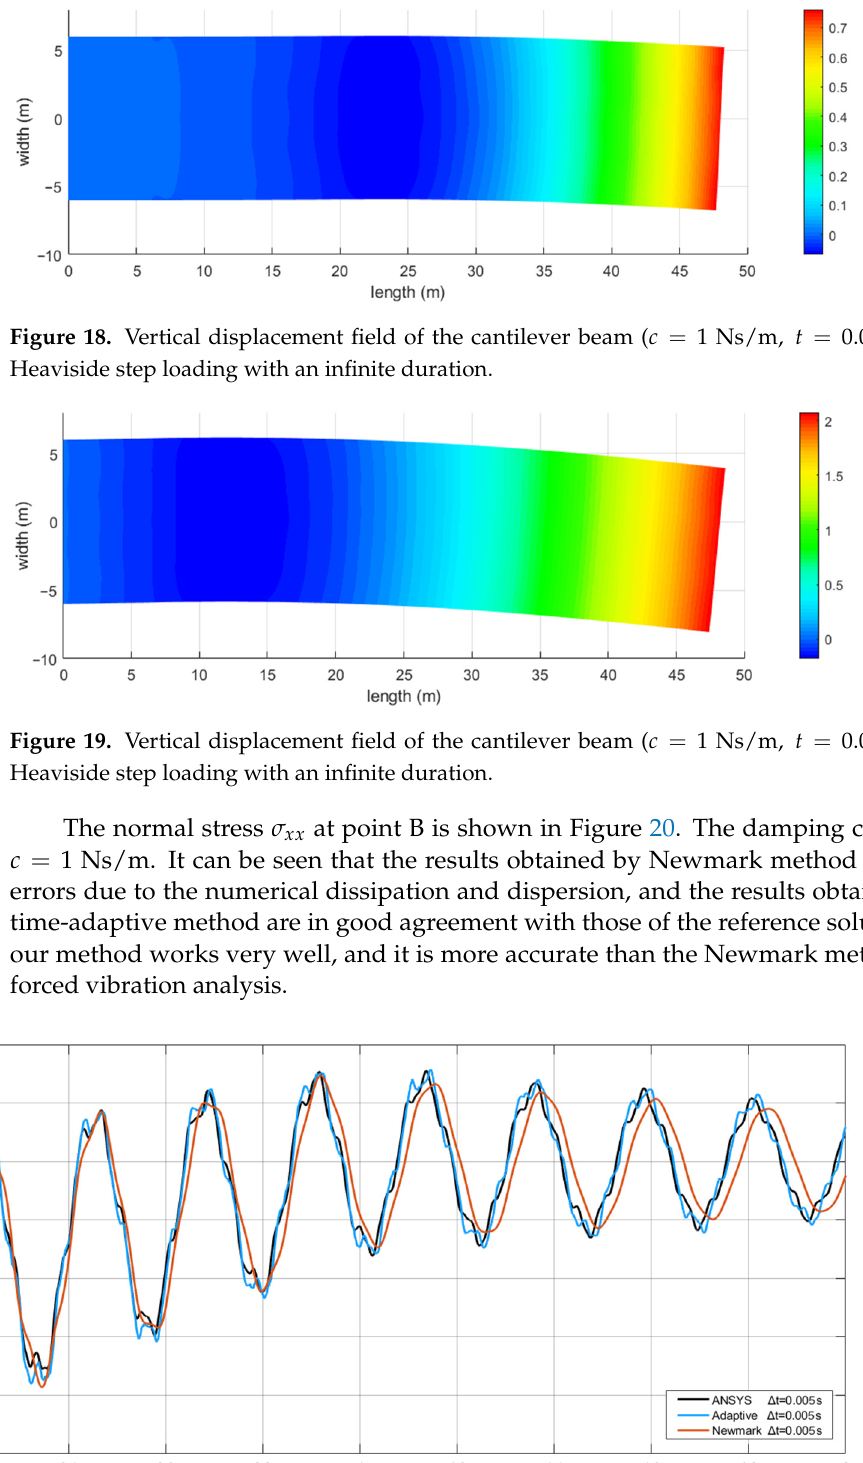
Figure 17. Vertical displacement field of the cantilever beam ( 𝑐 = 1 Ns/m,𝑡 = 0.005 s, ), under Heav- iside step loading with an infinite duration.